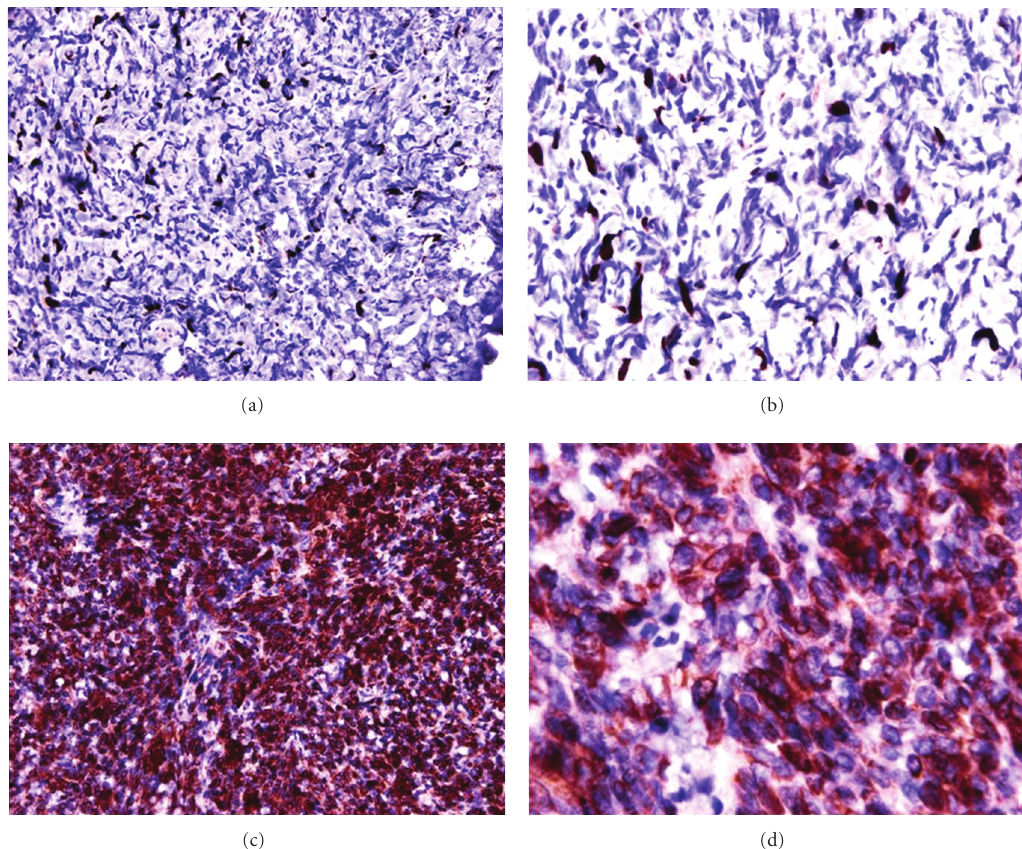
Figure 2: Immunohistochemical expression of CD34 and Ki67. Ki-67 showed a very low expression ((a) (20 XHPF) and (b) (40 XHPF)). The neoplastic cells express di ff usely CD34 immunoreactivity ((c) (20 XHPF) and (d) (40 XHPF)).